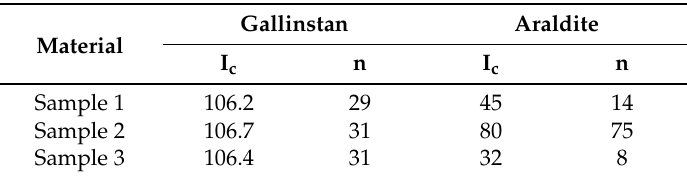
Figure 5. E-I curves with different impregnation materials. ( a ) Gallinstan; ( b ) Araldite. Table 2. Critical current and n values with different impregnation